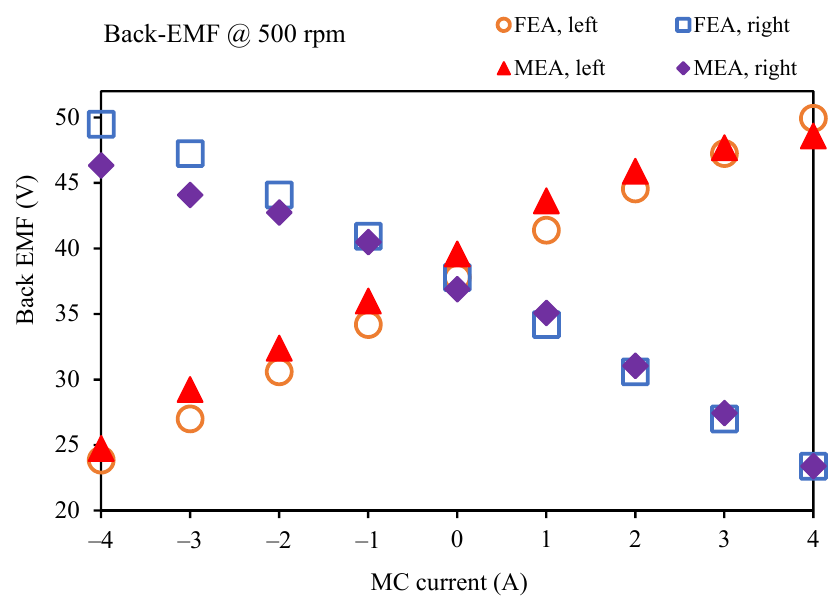
Figure 11. No-load back-EMFs with MC current on two rotors.